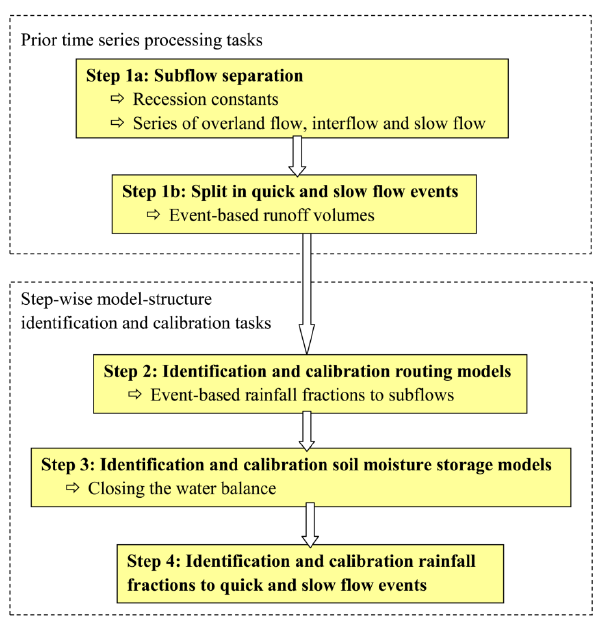
Figure 2: Steps in the VHM model structure identification and calibration procedure (adapted